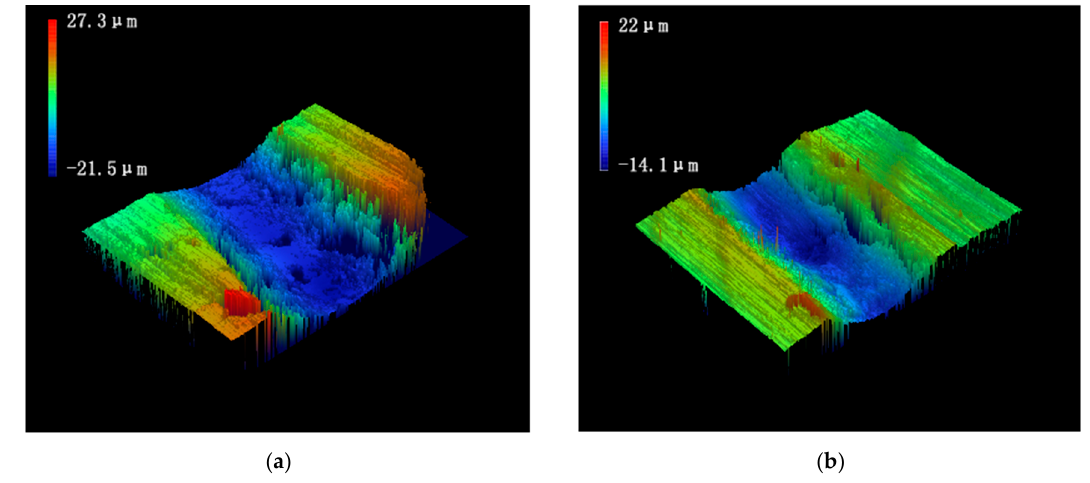
Figure 13. Friction and wear diagram of cladding layer at different scanning speeds: ( a ) 6# sample: